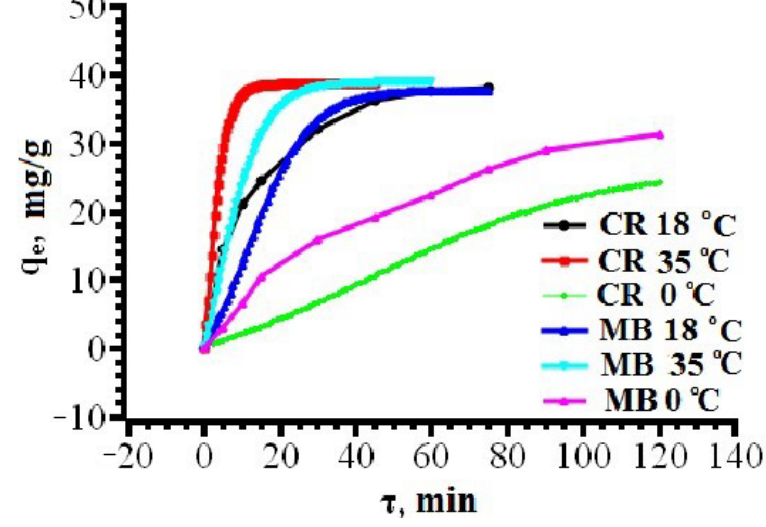
Figure 4. Dependence of adsorption on time.